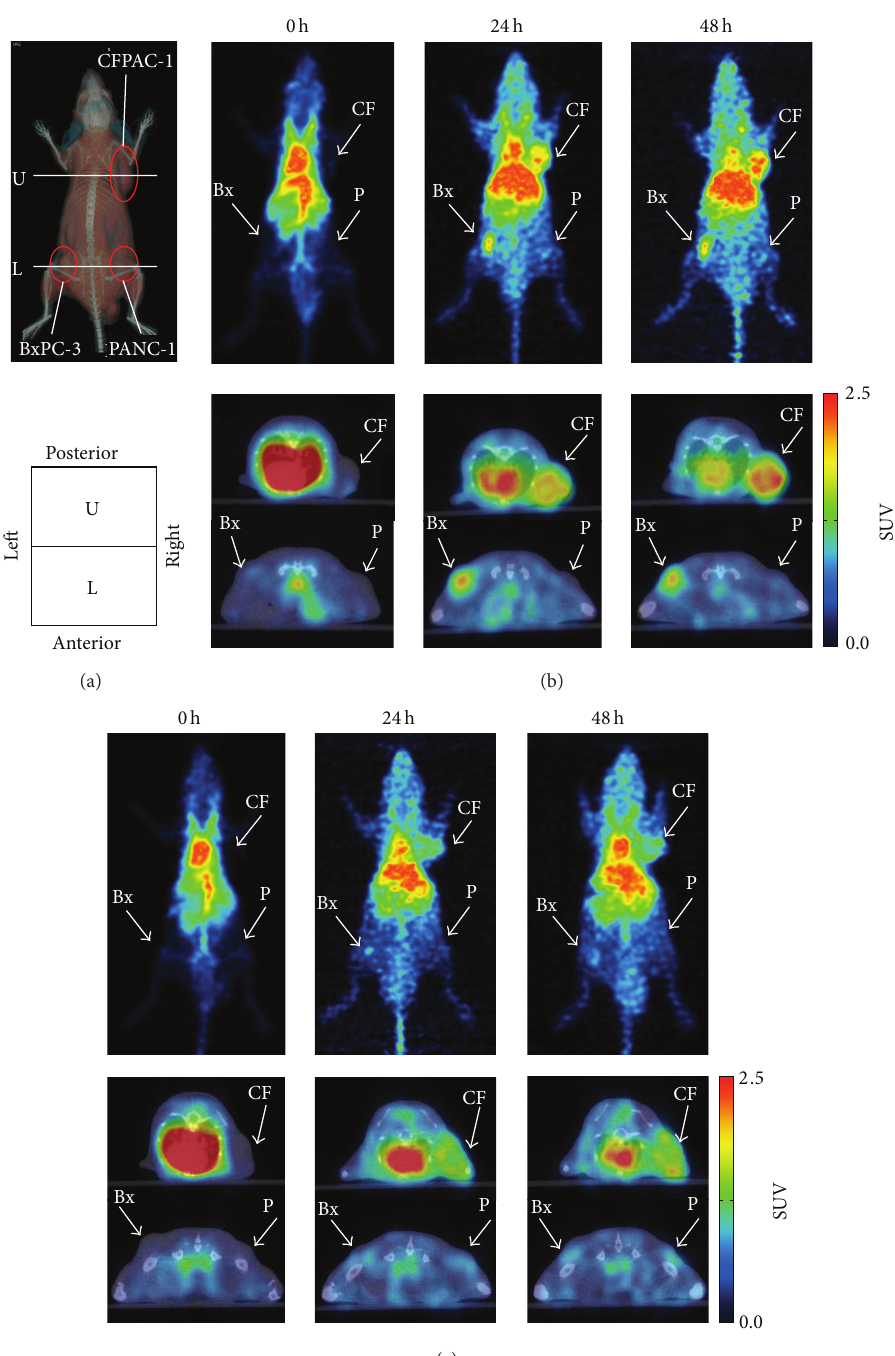
Figure 7: Representative PET images of mice bearing CFPAC-1, BxPC-3, and PANC-1. (a) A 3D volume rendering CT image of a mouse and a scheme showing the direction of PET images. The positions of xenografts and cross sections are shown on the CT image. CFPAC-1, BxPC-3, and PANC-1 xenografts were at the right shoulder, the left femur, and the right femur, respectively. (b) Serial PET/CT images of the nude mice at 0, 24, and 48 hours after administration of 64 Cu-DOTA-11-25 mAb and (c) 64 Cu-DOTA-anti-KLH mAb. Upper panels showed maximum intensity projections (MIP) of whole bodies. Lower panels are transverse PET/CT images at the position of tumors. Upper images (U) showed center of CFPAC-1 (CF), and lower images (L) showed BxPC-3 (Bx) and PANC-1